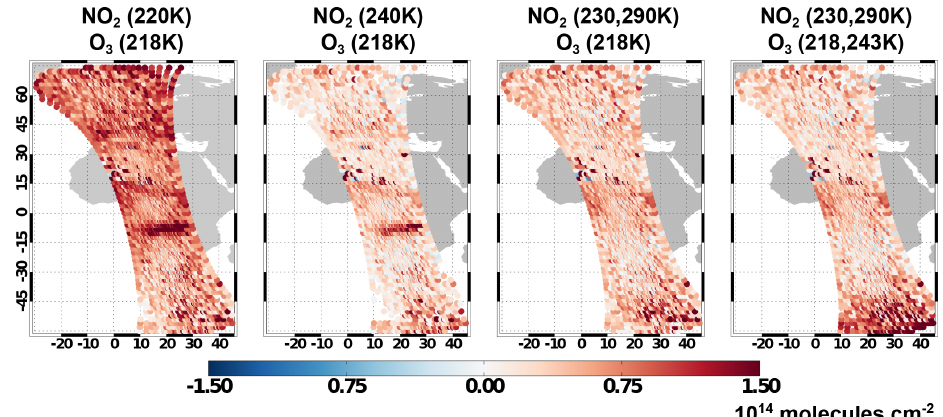
Figure 4. Differences between simulated and true glyoxal slant column densities (moleculescm − 2 ) retrieved using NO 2 and O 3 RCSs at different temperatures. Plot titles indicate temperatures of the RCSs used in the